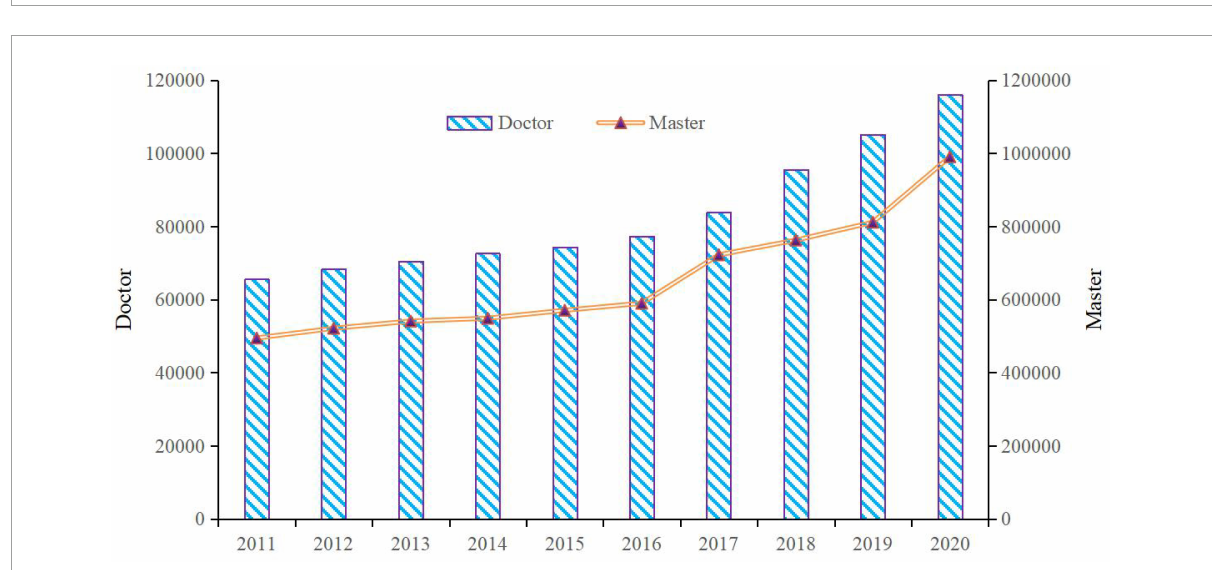
FIGURE2 Number of entrants of doctoral and master’s degree in China during 2011–2020 (person). Source: The author obtained the data from the Educational Statistical Yearbook of China. According to the brief introduction in the yearbook, the indicators of entrants of postgraduate students changed since 2017. The changed indicators do not influence analysis in this